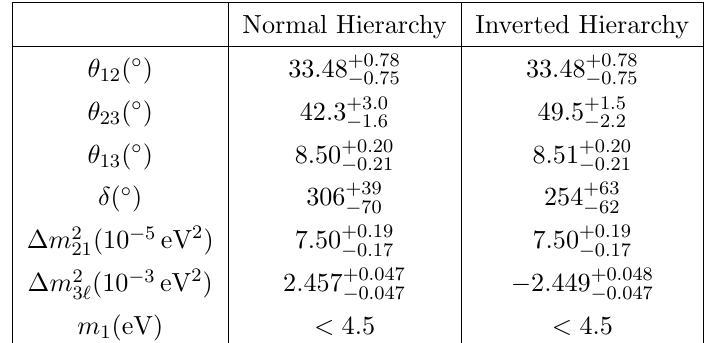
1 (cid:27) . In the case of (cid:1) m 2 , ‘ = 1 for the normal hierarchy 3 ‘ (cid:6)